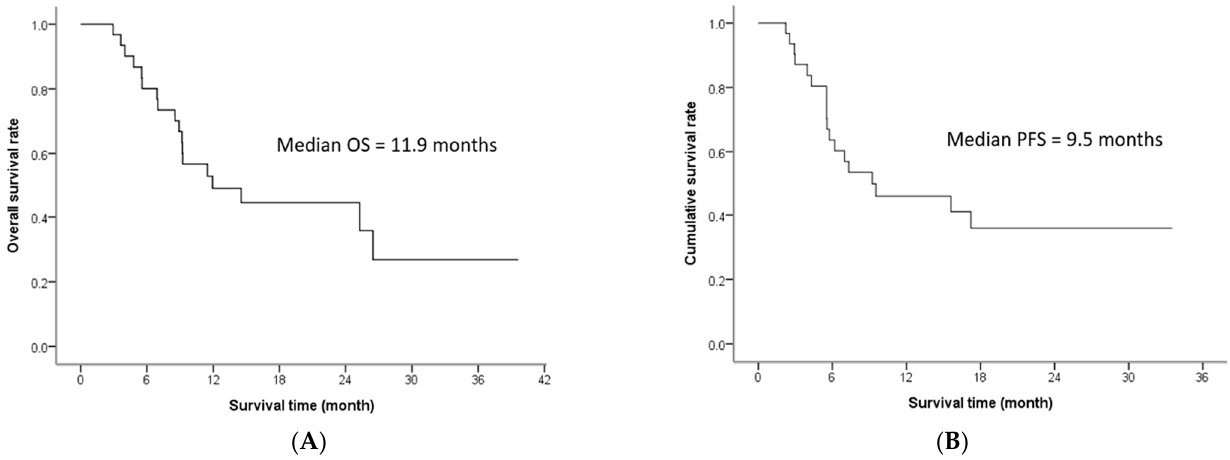
Figure 1. Overall survival ( A ) and progression-free survival ( B ). OS: overall survival; PFS: progression-free survival.